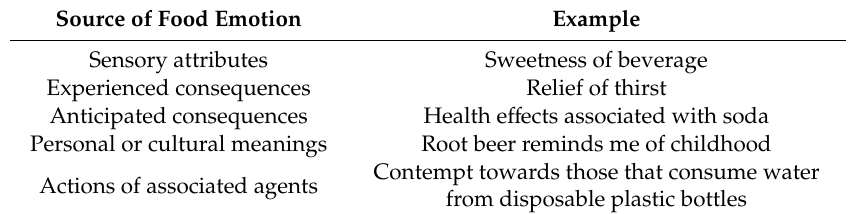
Table 2. Sources of food emotion and example stimuli for guidance of AFEA experimental design